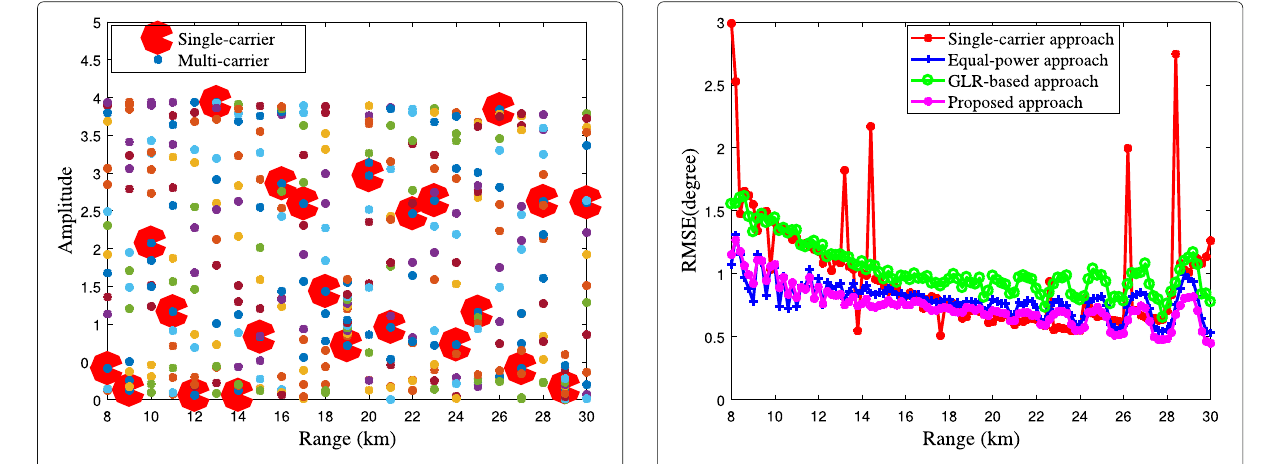
Fig. 6 Pattern propagation factor for single and MCPC waveform Fig. 7 RMSE versus